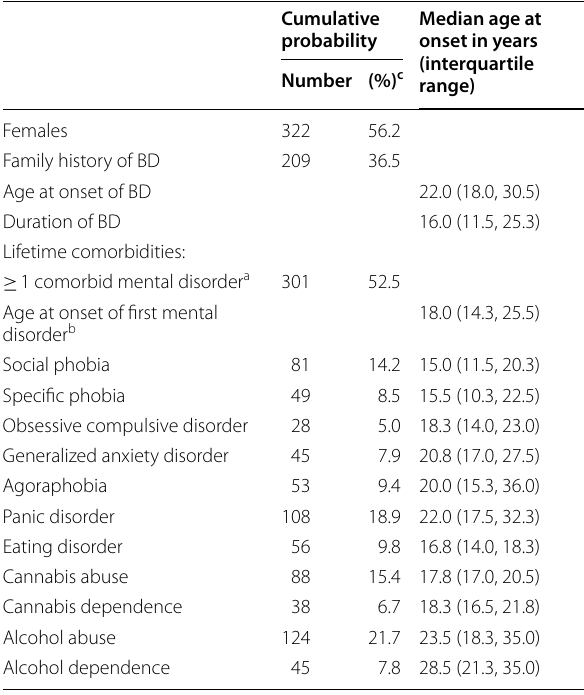
Table 1 Characteristics of 573 individuals with BD-I (209 with a family history and 364 without a family history of BD)